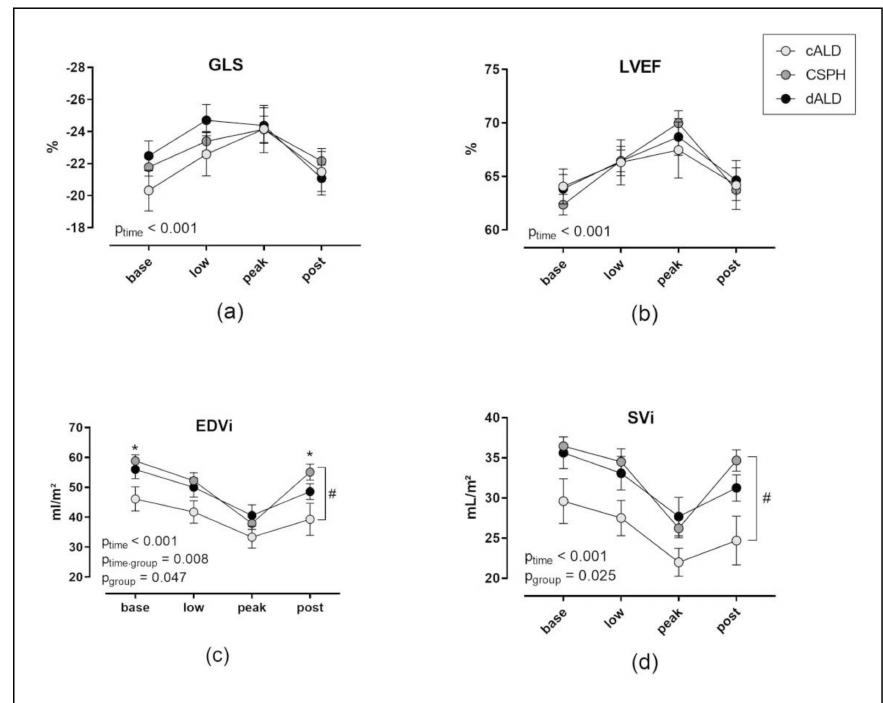
Figure 2. E ff ect of dobutamine stress echocardiography (DSE) on left ventricular function related to the severity of liver disease. The values at ‘base’ were recorded at rest before DSE, at ‘low’ with a dobutamine rate of 10 µ g / kg BW / min, at ‘peak’ with the maximum dobutamine rate and at ‘post’ after stopping dobutamine and returning to baseline heart rates (mean +/ − SD). The following parameters of left ventricular function are shown ( a ) global longitudinal strain (GLS), ( b ) left ventricular ejection fraction (LVEF), ( c ) end-diastolic volume index (EDVi) and ( d ) stroke volume index (SVi) (# p ≤ 0.05 between groups and * p < 0.05 vs. cALD at time